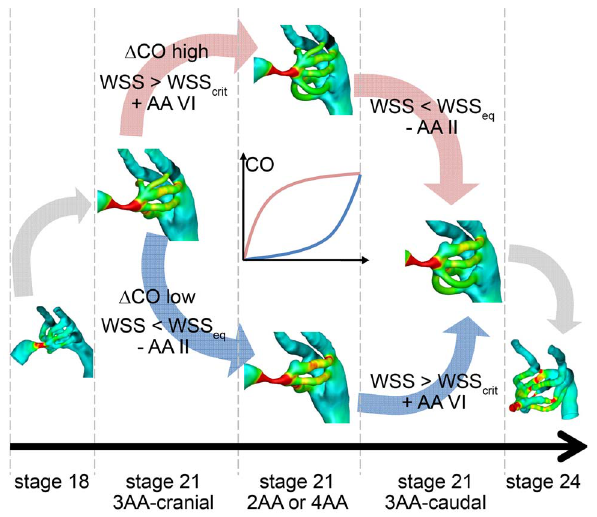
Figure 8. Theoretical growth pathways from stage 18 to stage 24 AA configurations. The transition can proceed through the 2AA or 4AA pattern depending on the timing of AA II regression and AA IV generation. WSS may be one factor in selecting the pathway, where levels above a critical value (WSS crit ) lead to AA generation and WSS below an equilibrium level (WSS eq ) leads to AA regression. The rate of increase in cardiac output (CO) can affect WSS levels.